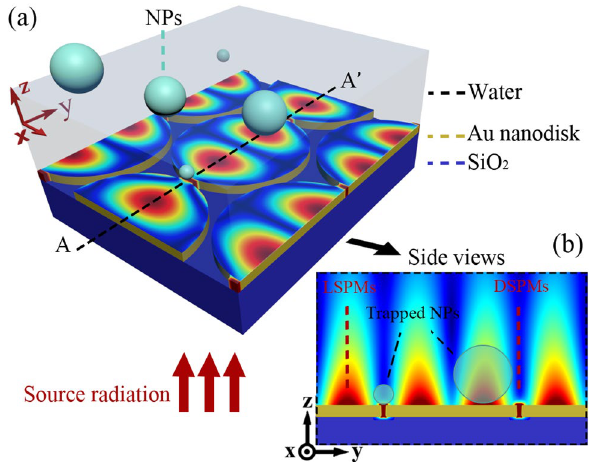
Figure 1. ( a ) Three-dimensional, and ( b ) side view schemes of the proposed closed pack array of gold nano- discs with a qualitative representation of the excited plasmonic